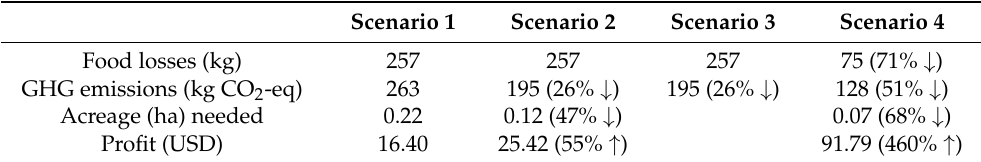
Table 11. Losses, GHG emissions, Acreage needed and Profitability per ton of Product at point of sale. Percentage Difference (positive (upward arrow) or negative (downward arrow)) with Reference Scenario Shown in Parentheses.